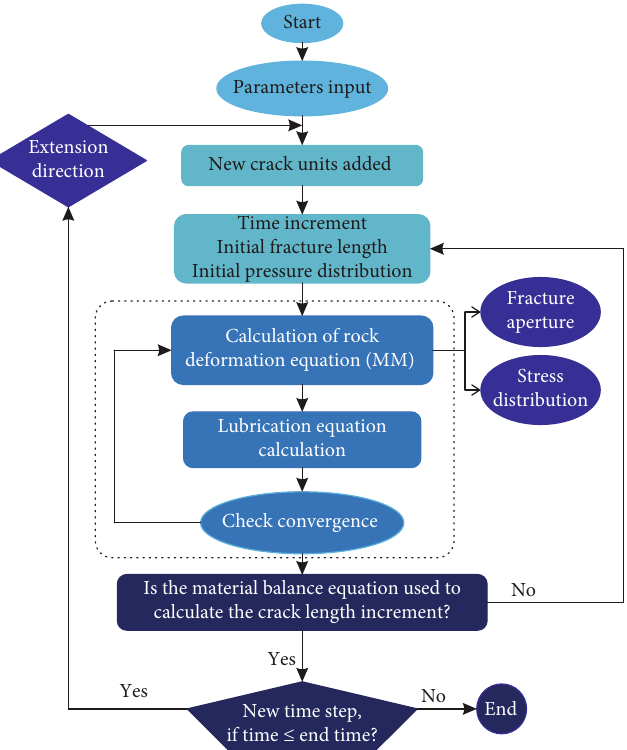
Figure 3: Flow chart of calculation